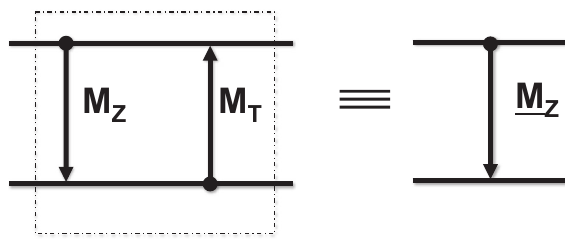
Fig. 1 Equivalence of measurers. A measurer M Z of Z acting on S Q composed with a measurer M T of T on S C is equivalent to a different realisation M z of a measurer of Z on S